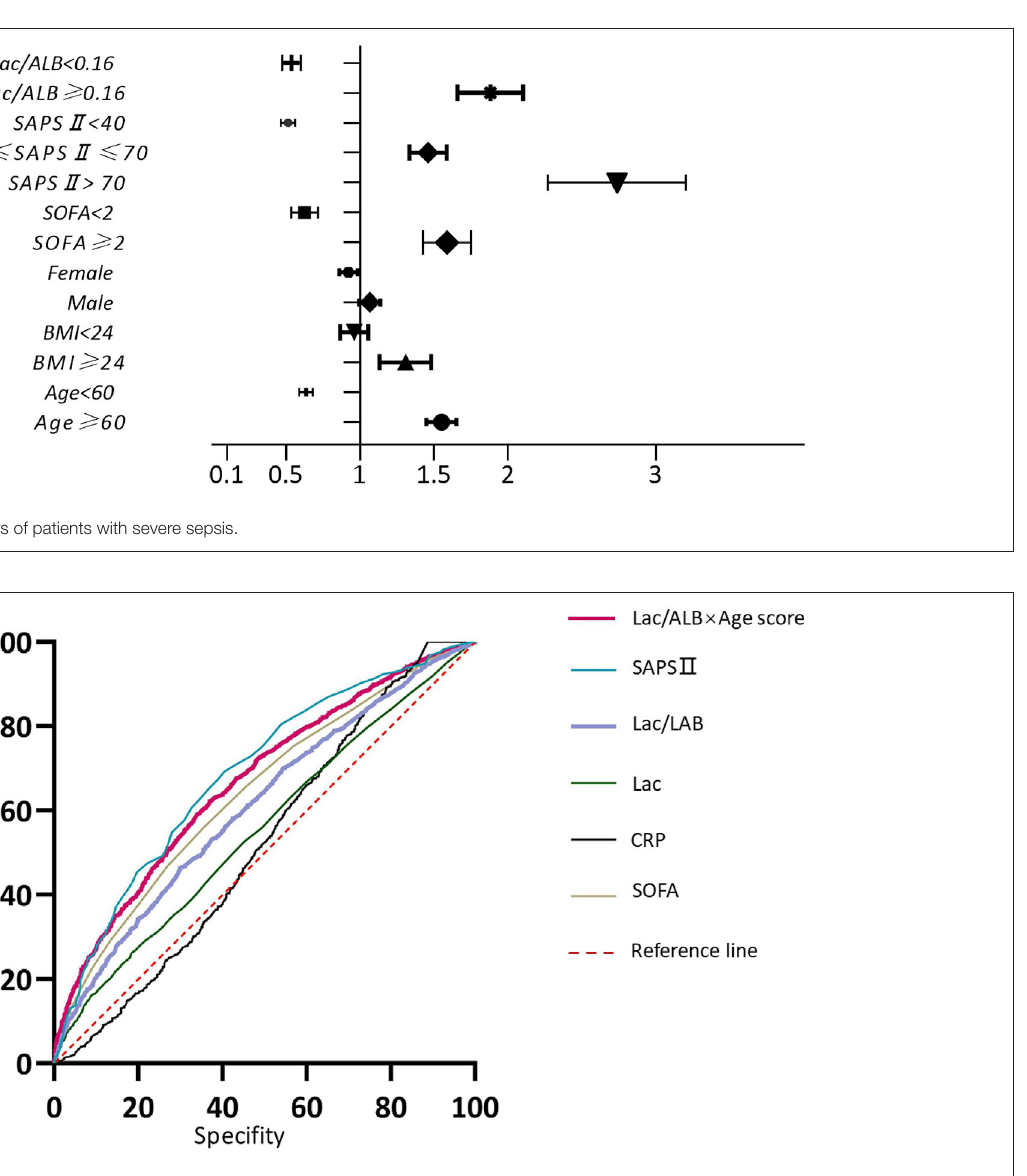
FIGURE 5 | Prognostic value of indicators for predicting adverse outcomes in sepsis